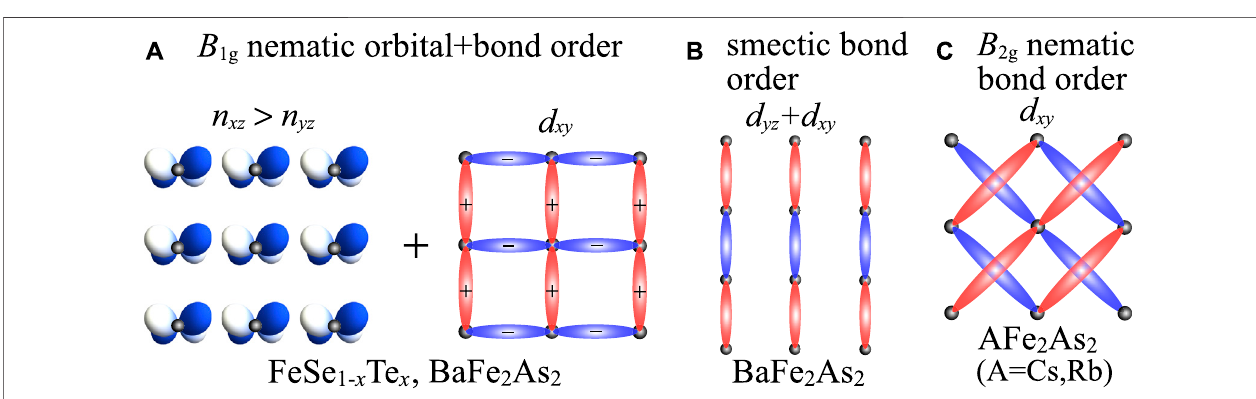
FIGURE14|(A) Schematicpictureofthe B 1 g nematicorbital+bondorderinFeSe 1 − x Te x andBaFe 2 As 2 ,wheretheorbitalorderforthe d xz and d yz orbitalscoexists withthebondorderforthe d xy orbital. (B) Schematicpictureofthesmecticbondorderfor d yz and d xy orbitalsinBaFe 2 As 2 . (C) Schematicpictureofthe B 2 g nematicbond order for the d xy orbital in AFe 2 As 2 (A = Cs,